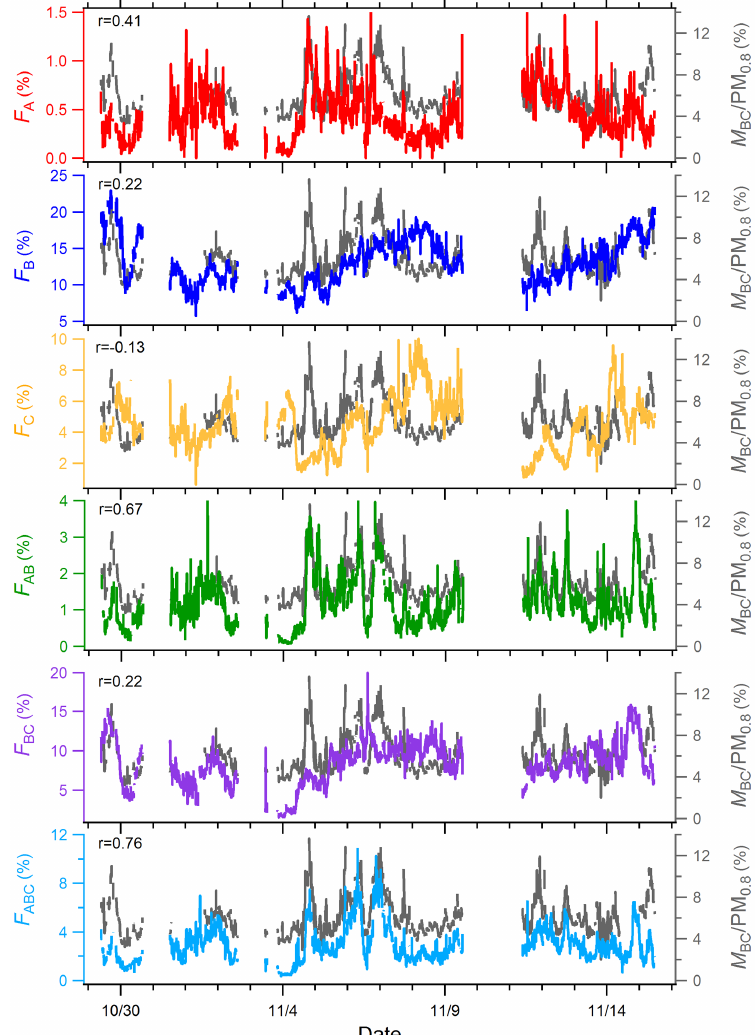
Figure 7. Time series of number fractions of various fluorescent particles (left axis) and M BC / PM 0 . 8 (gray, right axis). r is the correlation coefficient between F x and M BC / PM 0 . 8